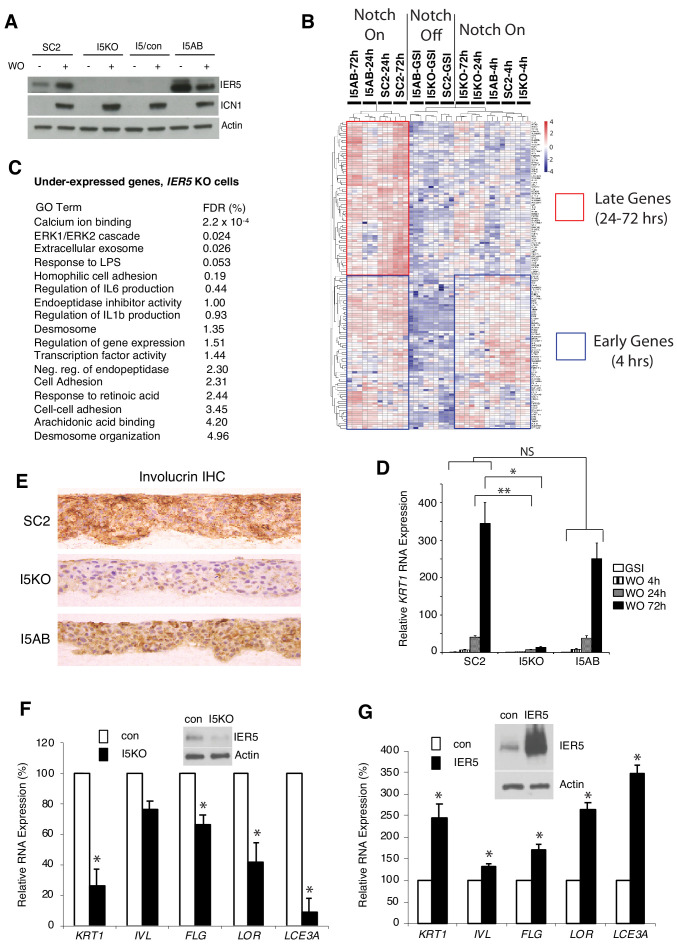
Effect of IER5 on Notch-dependent changes in gene expression in SC2 cells and NOK1 cells.(A) Western blots showing IER5 and ICN1 protein levels in SC2 cells, a single-cell clone derived from SC2-IER5 knockout cells (I5KO), I5KO cells transduced with empty virus (I5/con), and pooled I5KO cells transduced with IER5 cDNA (I5AB) that were maintained in GSI (-) or harvested 48 hr post-GSI washout (+). (B) Heat map showing Notch-induced changes in gene expression in SC2 cells, I5KO cells, and I5AB cells. RNA-seq was performed in biological replicates in triplicate at time 0, 4 hr, 24 hr, and 72 hr after GSI washout. Samples were subjected to unsupervised clustering using a gene set containing all genes that were significantly upregulated at any time point after Notch activation in SC2 cells. The blue boxes highlight genes that are upregulated at 4, 24, and 72 hr after Notch activation, whereas the red box highlights genes that are under-expressed in IER5 knockout cells (I5KO) and rescued by re-expression of IER5 (I5AB) at later timepoints (24 and 72 hr). (C) Gene ontogeny (GO) terms associated with the set of under-expressed genes in I5KO cells following Notch activation. FDR = false discovery rate. (D) Diminished induction of KRT1 expression at 24 and 72 hr after GSI WO in I5KO cells is prevented by IER5 addback (I5AB cells). Transcript abundance in biological replicates prepared in triplicate was measured by RT-PCR and normalized against GAPDH. Error bars represent standard deviations of the mean. *, p<0.05; **, p<0.005; NS, not significant (two-tailed student t test). (E) Immunohistochemical staining for involucrin in SC2, I5KO, and I5AB cells in raft cultures grown in the absence of GSI. (F, G) Effect of CRISPR/Cas9 targeting of IER5 and enforced IER5 expression on differentiation-associated transcripts in NOK1 cells. In F, NOK1 cells were transduced with CRISPR/Cas9, GFP, and IER5 (I5KO) gRNA or AAVS1 control (con) gRNA and sorted for GFP positivity. In G, NOK1 cells were transduced with empty GFP-expressing retrovirus (con) or IER5 and GFP and sorted. In F and G, analyses were done on pooled GFP-positive transductants, which were moved to high Ca2+ medium for 3 days (F) or 5 days (G) prior to harvest. Inset western blots show the extent of IER5 loss (F) and IER5 overexpression (G) relative to control cells. In F and G, transcript abundance was measured in biological replicates prepared in triplicate by RT-PCR and normalized against GAPDH. Error bars represent standard deviations of the mean. *, p<0.05, student two-sided t test.